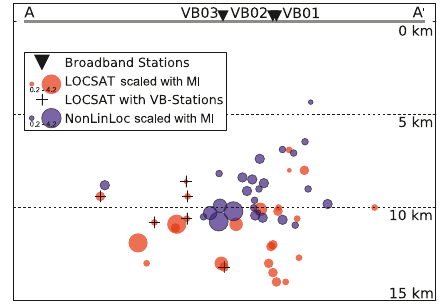
Figure 3. Earthquake depth distribution along profile A (see Fig. 2 for